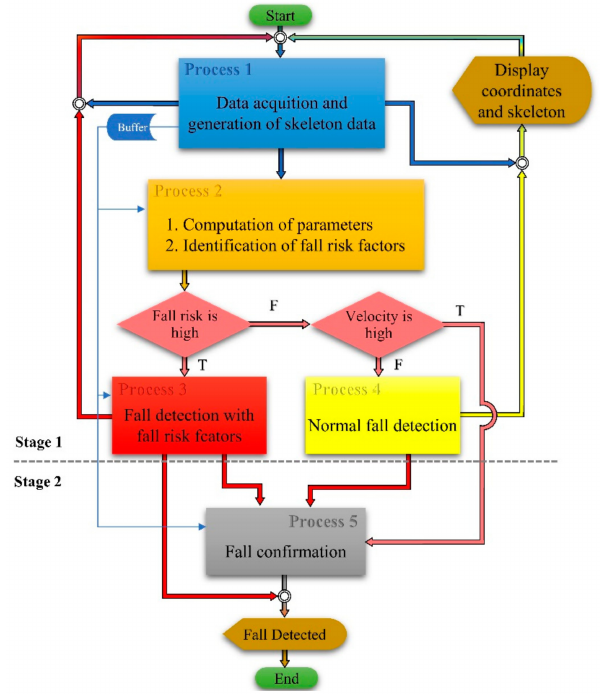
Figure 3. Proposed fall detection